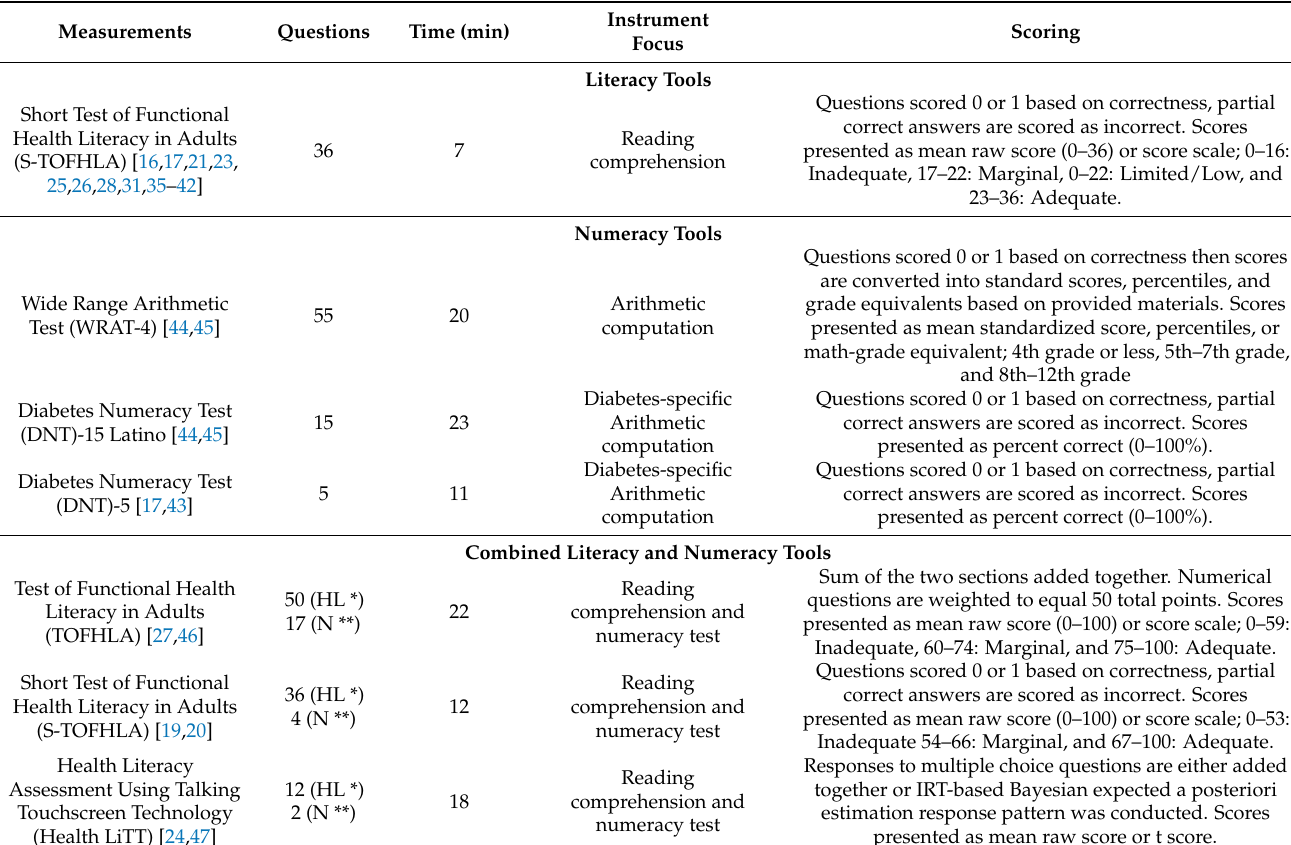
Table 1. Direct assessment health literacy and numeracy instruments found in publications having Hispanic populations with